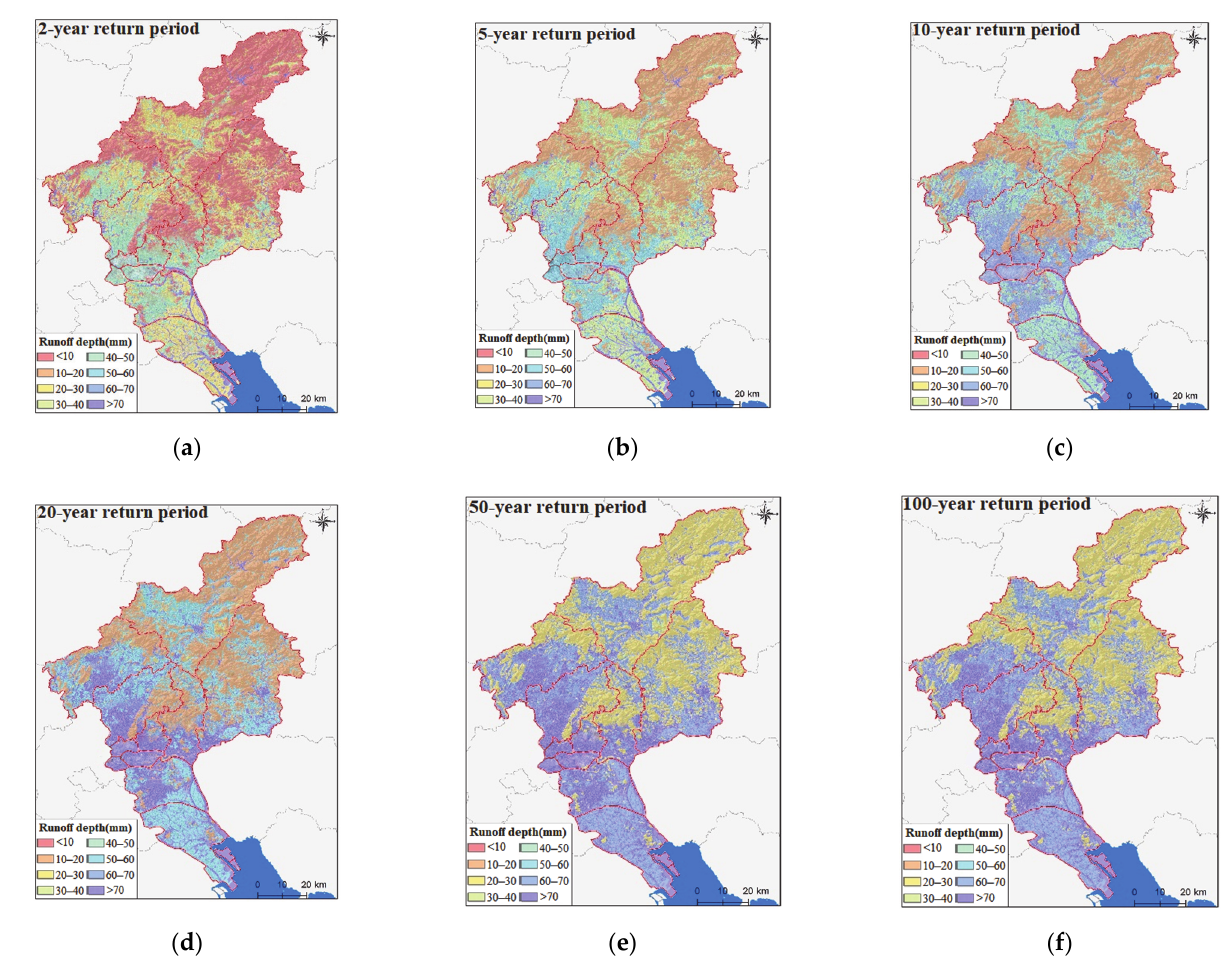
Figure 5. Spatial distribution of runoff depth under different precipitation scenarios: ( a ) 2-year return period; ( b ) 5-year return period; ( c ) 10-year return period; ( d ) 20-year return period; ( e ) 50-